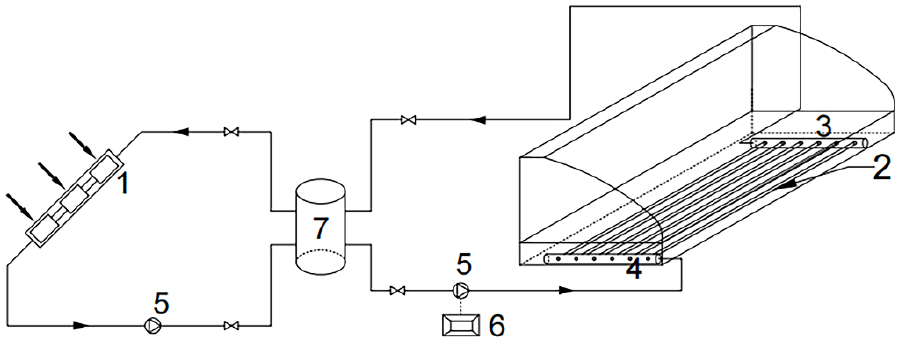
Figure 2. Schematic diagram of solar soil heating system. (1. solar collector, 2. horizontal heating pipes, 3. water collector, 4. water separator, 5. water pump, 6. controlling cabinet, 7. water storage tank.).